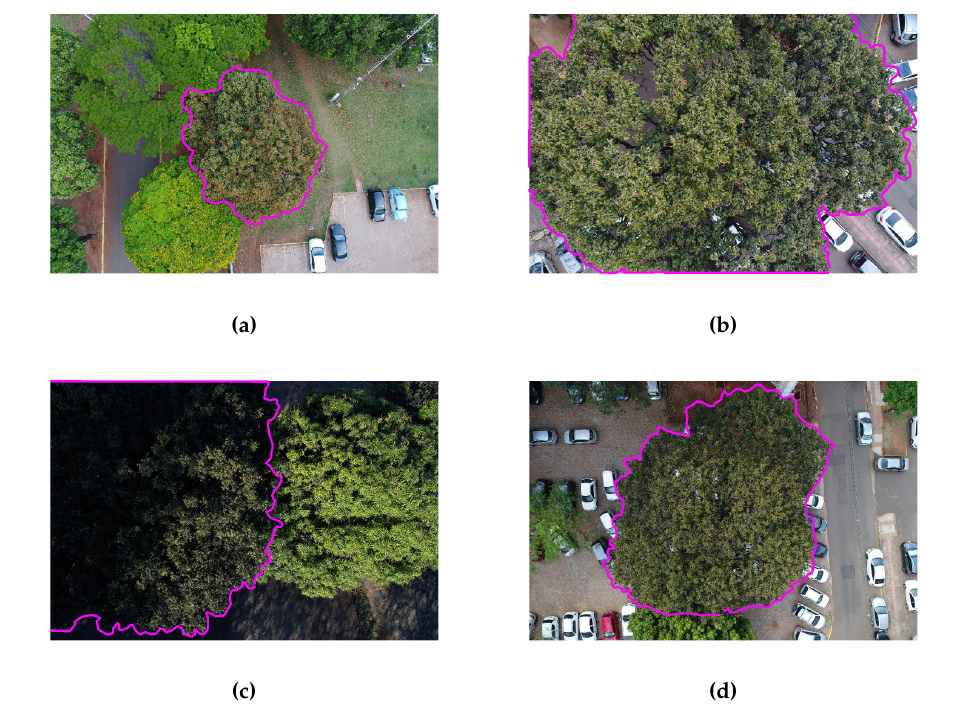
Figure 2. Image samples with the reference tree contour in pink, showing variations in terms of scale ( a , b ), illumination ( c ), and different urban patterns ( d